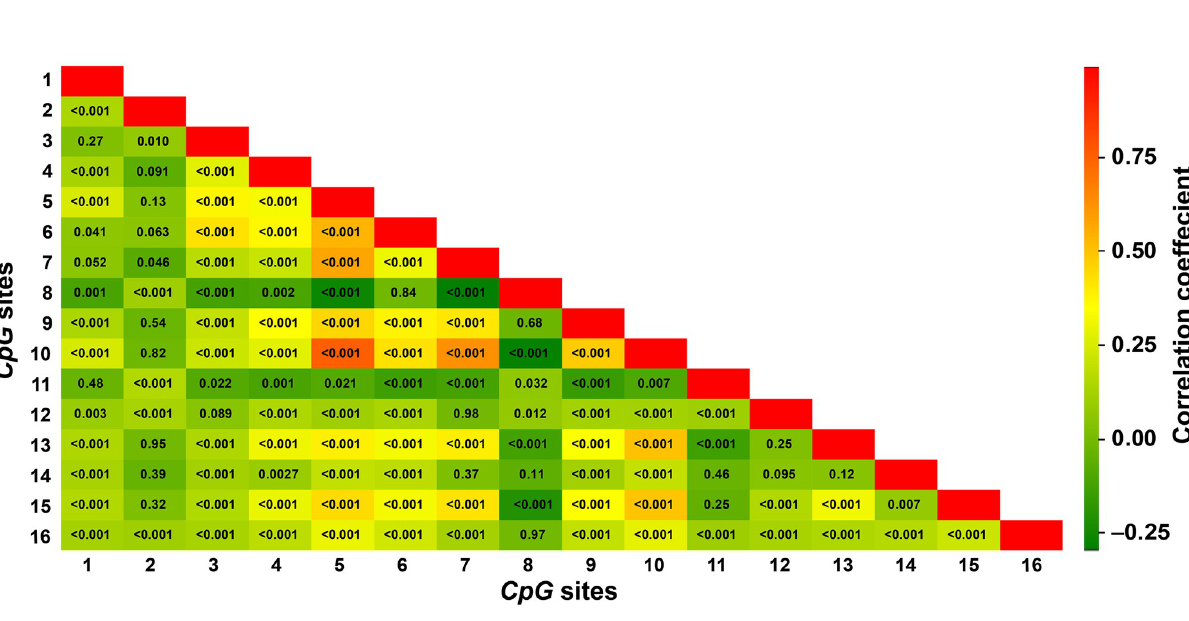
Fig 3. Correlation coefficients of the methylation level at 16 analysed CpG sites. The colour indicates the direction and magnitude of the correlation coefficients and the number within each box the